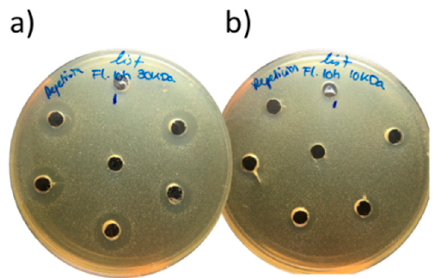
Figure 4. Antimicrobial activity of porcine liver hydrolysates using Flavourzyme during 10 h for 30-kDa ( a ) and 10-kDa ( b ) against Listeria monocytogenes .